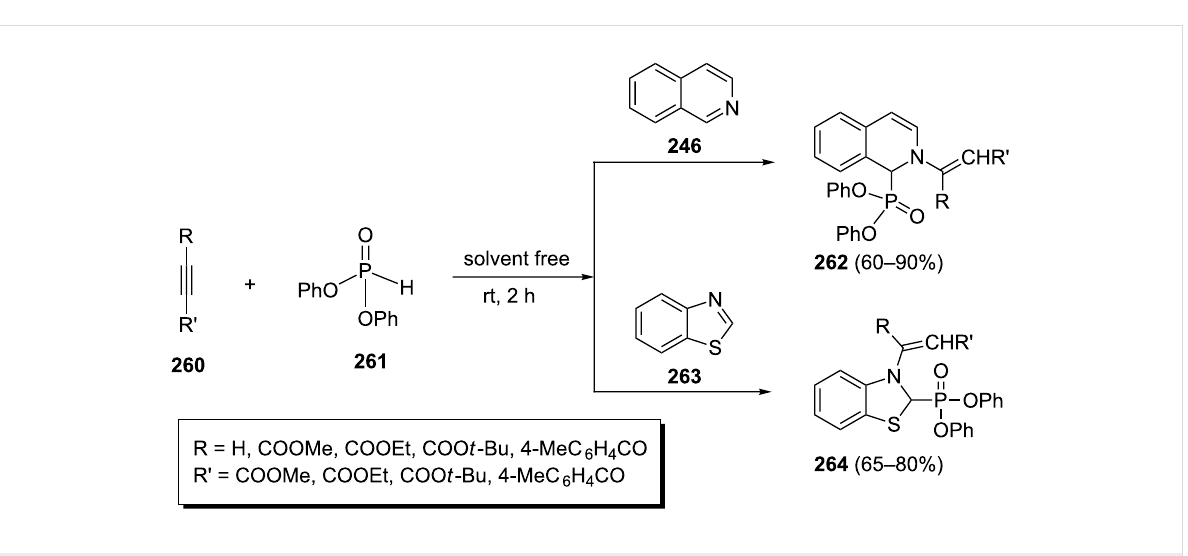
Scheme 54: Three-component reactions for the phosphorylation of benzothiazole and